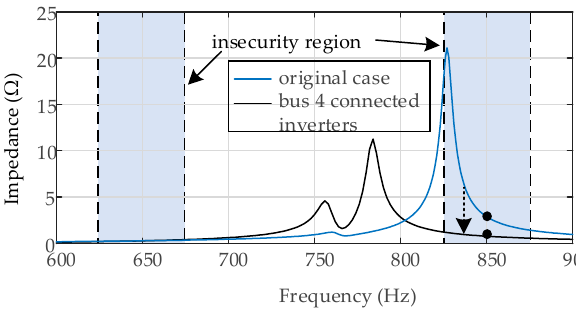
Figure 16. Frequency scan diagram of bus 4.